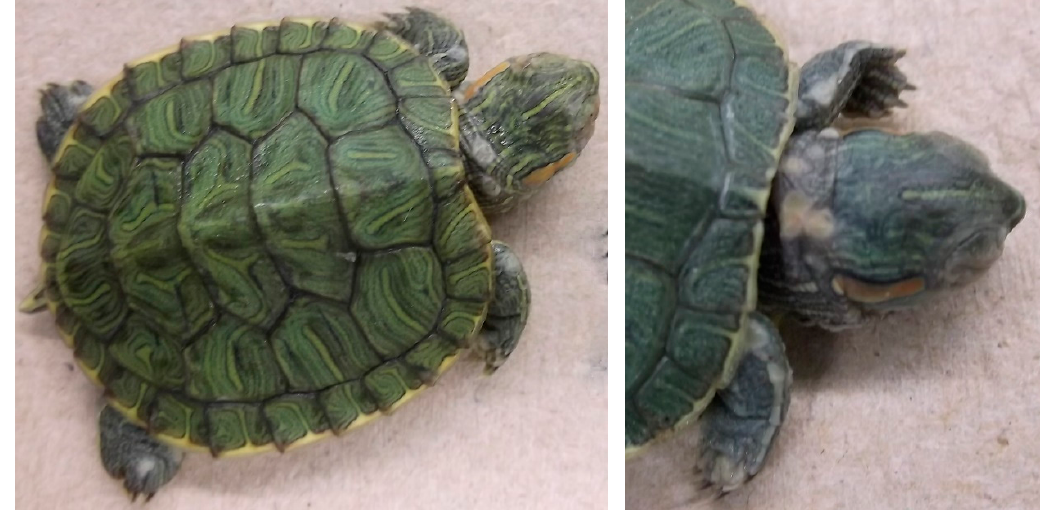
Figure 2. Representative images of white growths occurring on skin of hatching turtles ( Trachemys scripta elegans ), suspected as an unidentified fungal pathogen. Two different individuals are shown, with growths visible on the limbs and neck.